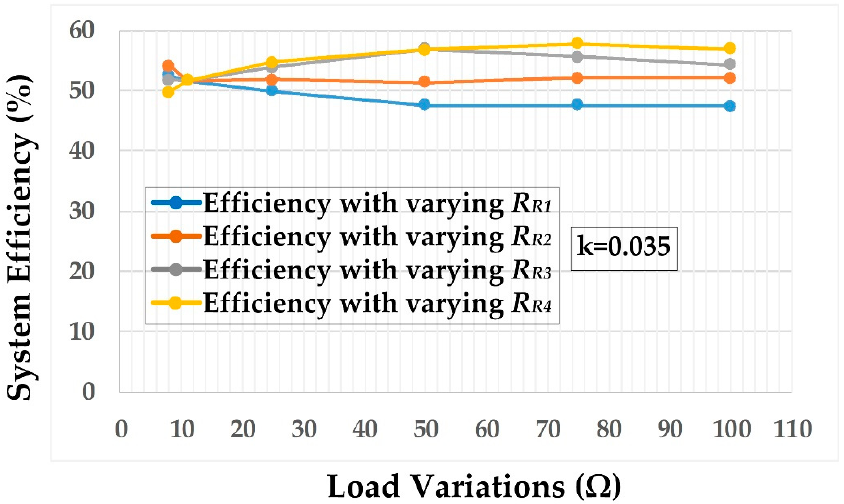
Figure 10. System efficiency against one of the load variations.